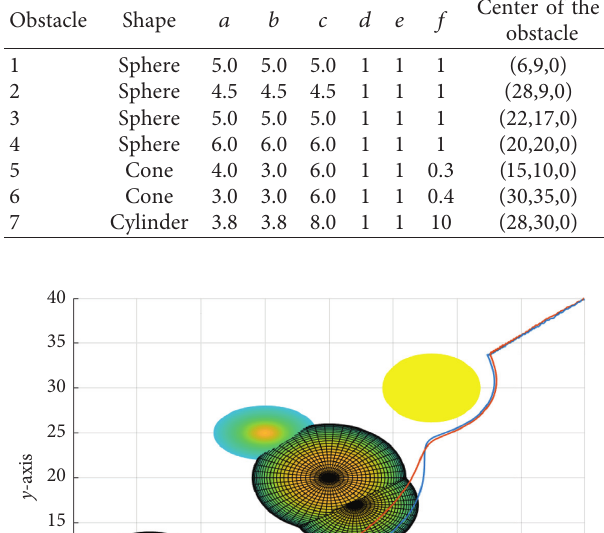
Center of the obstacle